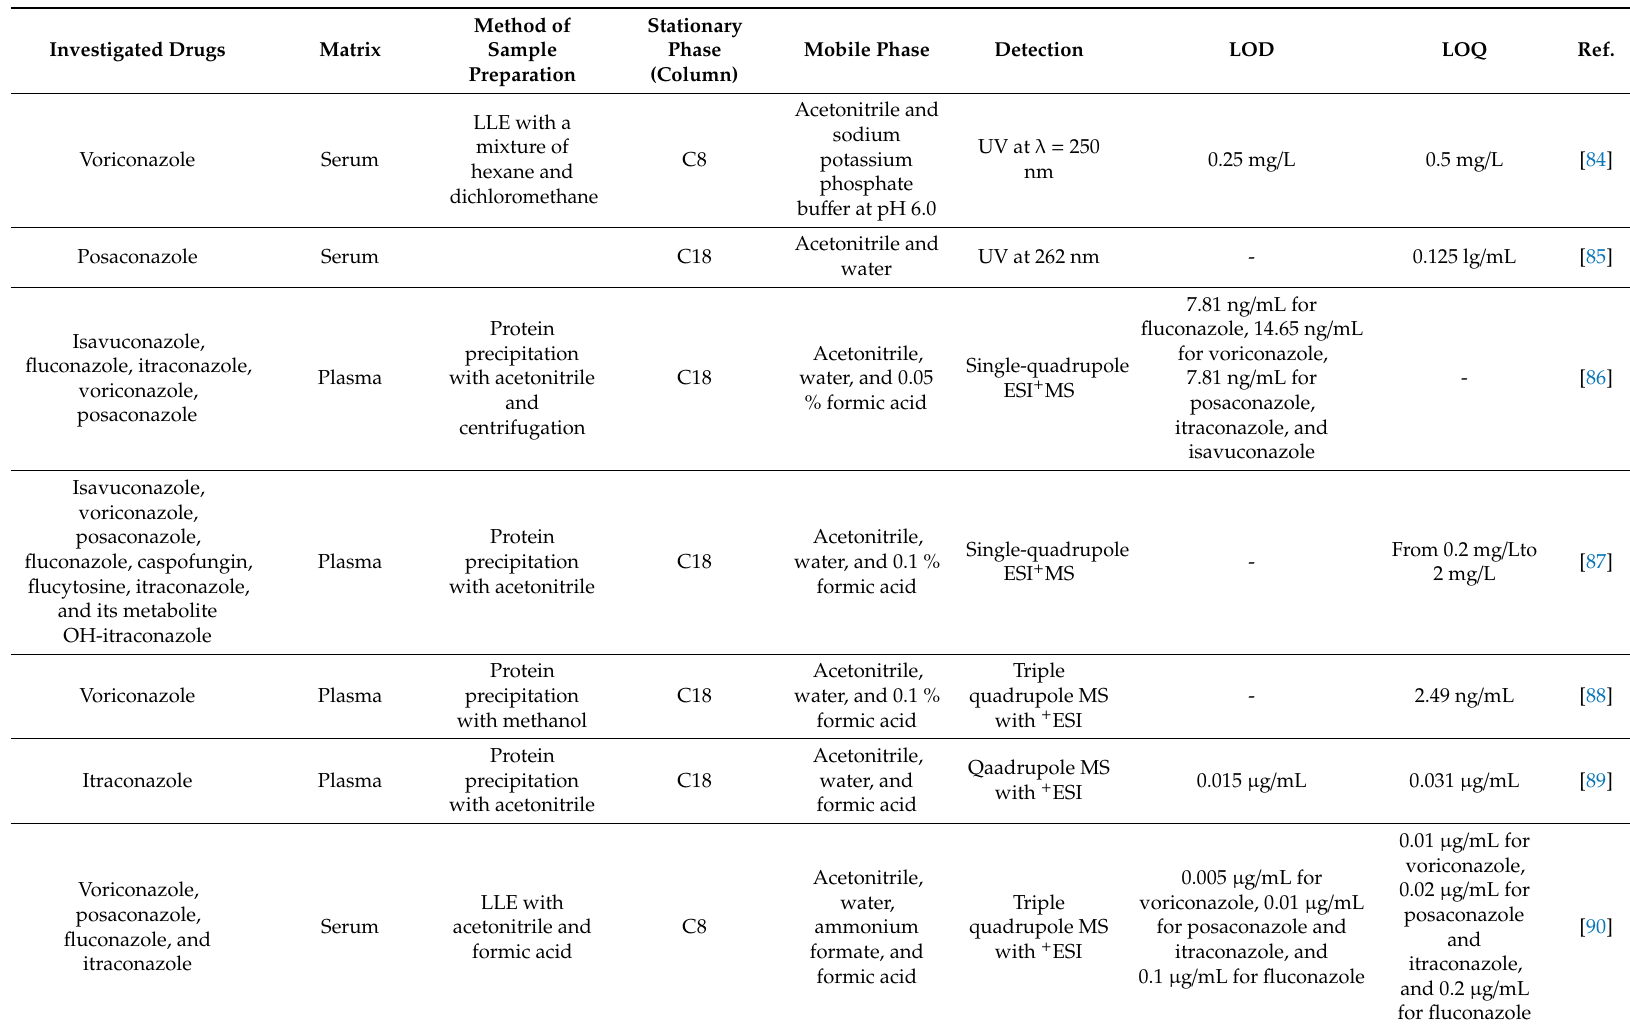
Table 4. Antifungal